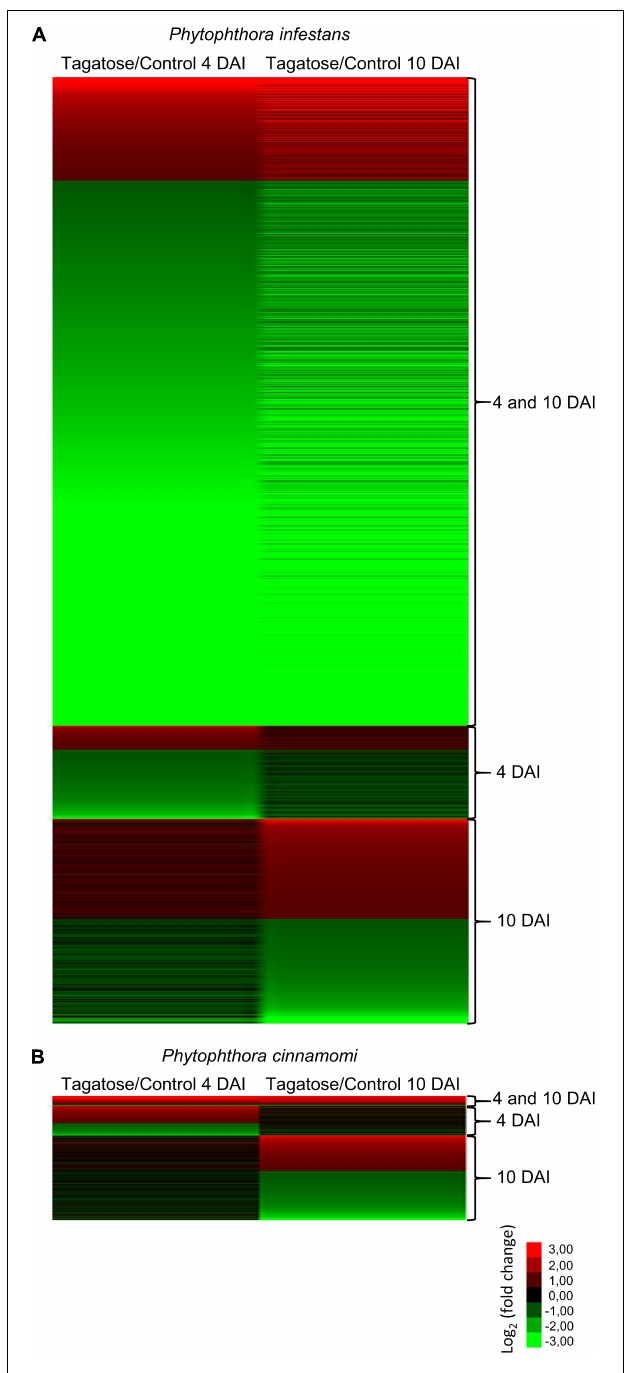
FIGURE 2 | Clustering of genes modulated by tagatose in Phytophthora spp. Heat map diagram of fold change values of differentially expressed gens (DEGs) identified in Phytophthora infestans (A) and P. cinnamomi (B) at 4 and 10 days after incubation (DAI) on pea agar medium in the presence of tagatose compared to the respective control samples grown in the absence of tagatose. For each Phytophthora spp., DEGs were grouped in genes significantly upregulated or downregulated at both time points (4 and 10 DAI cluster) and exclusively modulated at 4 DAI (4 DAI cluster) or at 10 DAI (10 DAI cluster). The heat map diagram was visualized using Java Treeview according to the color scale legend